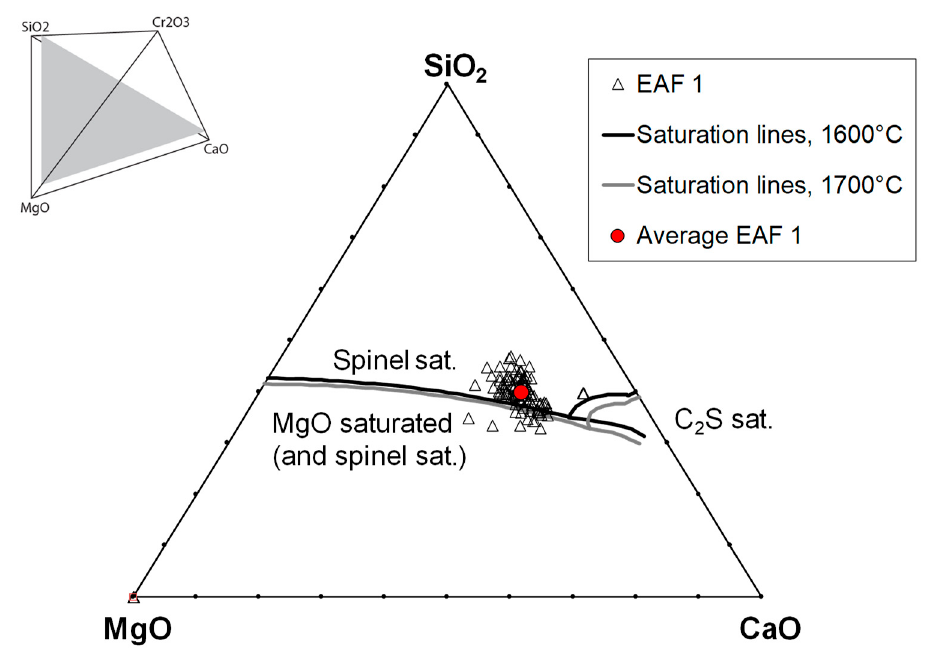
Figure 4. Slag compositions at tapping from EAF 1 versus saturation lines of MgO and C 2 S. Saturation lines are calculated by FactSage (reproduced from [13]) in the system CaO-MgO-SiO 2 -5wt.Al 2 O 3 -3~10 wt.Cr 2 O 3 at 1600 °C and 1700 °C (see Figure 3).